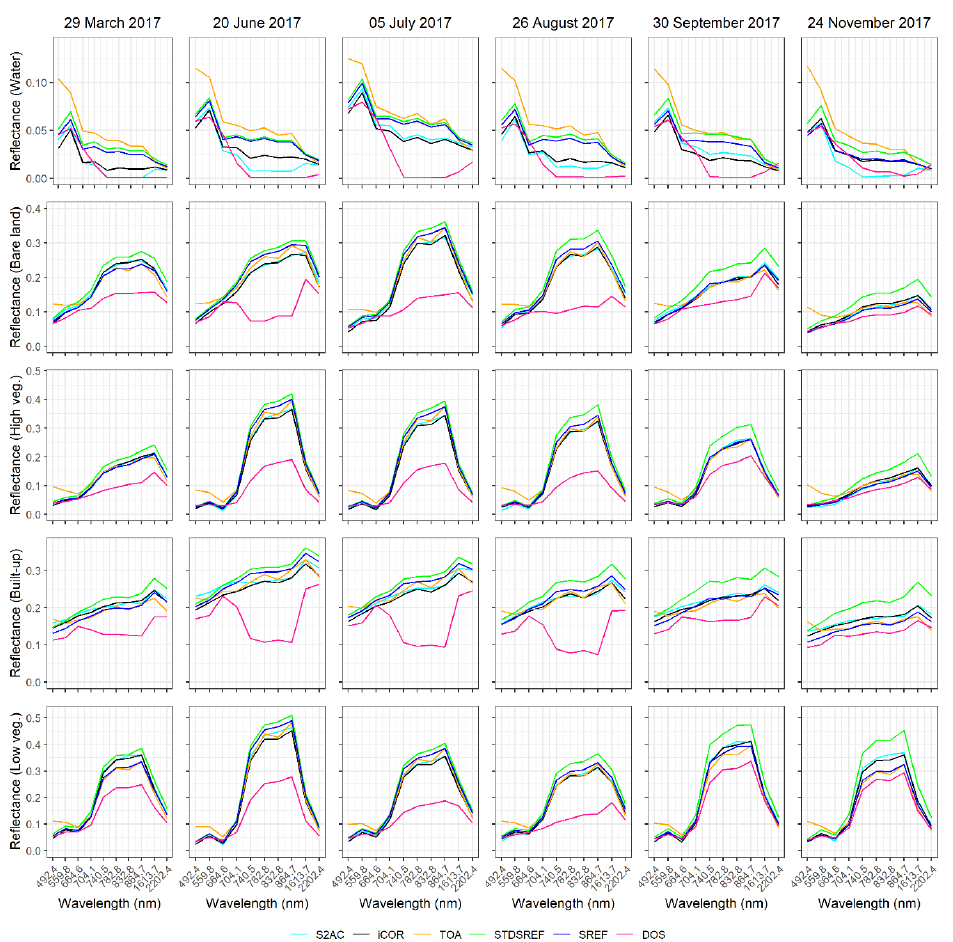
Figure 3. Sentinel-2 spectral signatures of five atmospheric corrections and top of the atmosphere (TOA) on five land cover classes for the year 2017. Figure 4 represents spectral signatures of 6 atmospheric corrections for 6 Sentinel-2 images in 2018. The analysis was conducted the same as for 2017. DOS correction has the lowest values for almost all wavelengths and all dates. On the other hand, TOA has the highest values for water class for visible (red, green blue) and NIR spectrum, while for other bands STDSREF has the highest values. STDSREF has the highest value for bare land, built-up land, high and low vegetation, for all dates in 2018.